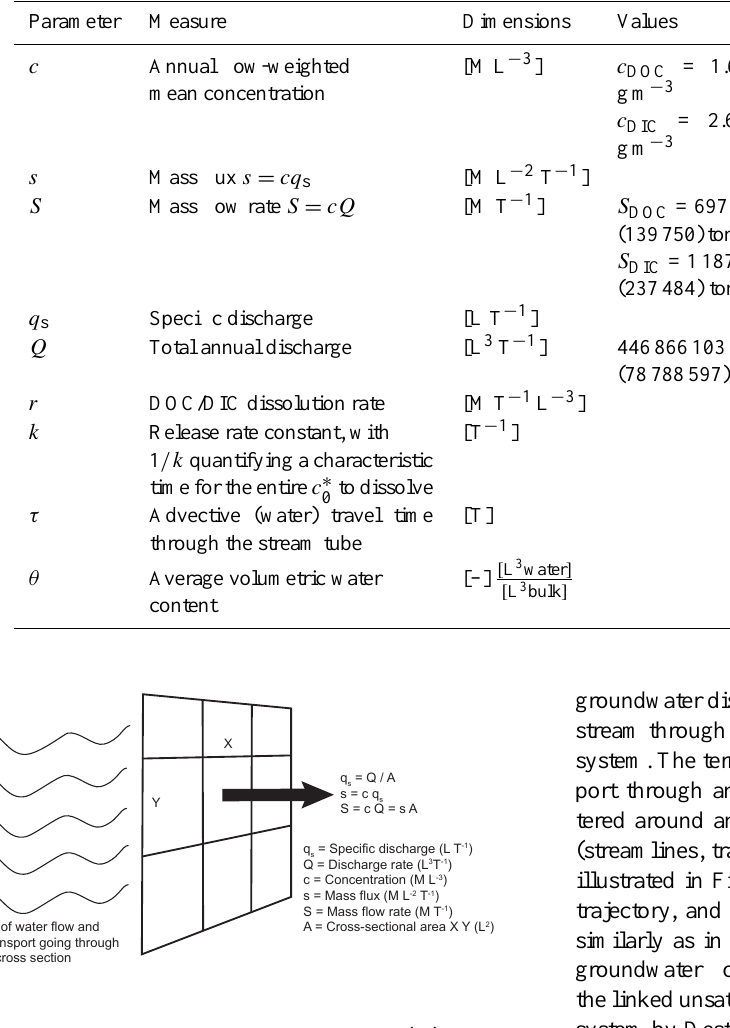
Fig. 2. Schematic representation of specific discharge ( q s ) and mass flux ( s ) in terms of concentration ( c ) and discharge flow rate ( Q ) with associated cross-sectional area ( A